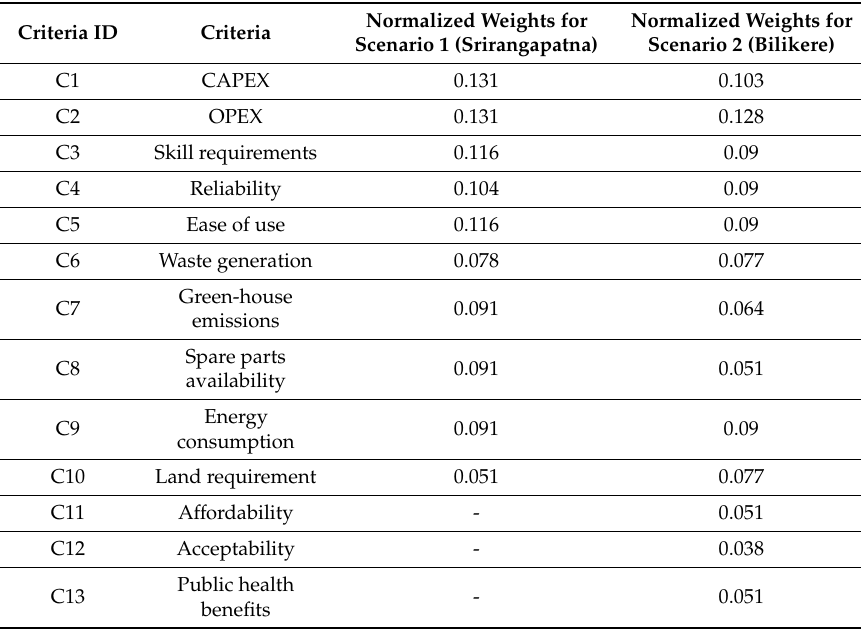
Table 4. Importance weights given to criteria in Scenarios 1 and